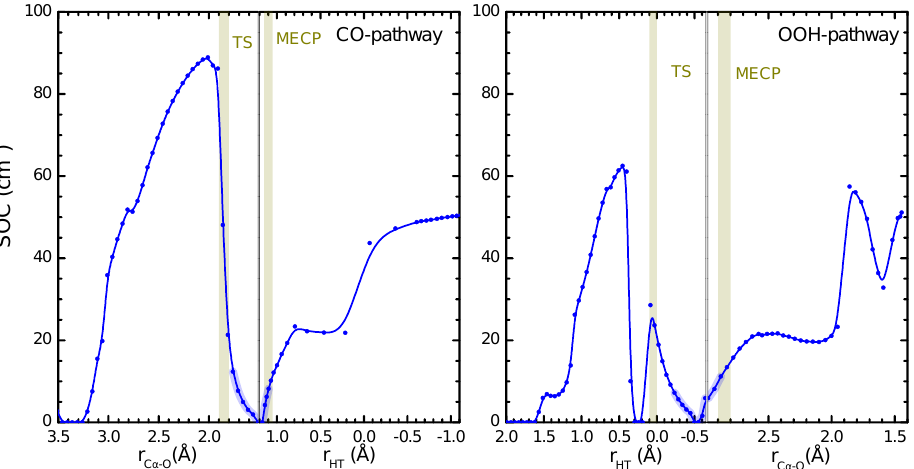
Figure 6. Spin -orbit coupling (SOC) between the ground triplet state and the singlet state involved in the oxidation of 2-methyl-3,4-dihydro-1-naphthol. Calculations carried out at the CASPT2(8,5)/maug- cc-pVDZ theory level. Dots represent the actual values, while the solid lines are displayed to guide the eye. The regions for which singlet and triplet states are almost degenerate are highlighted, as they represent the regions for where hopping is more likely to